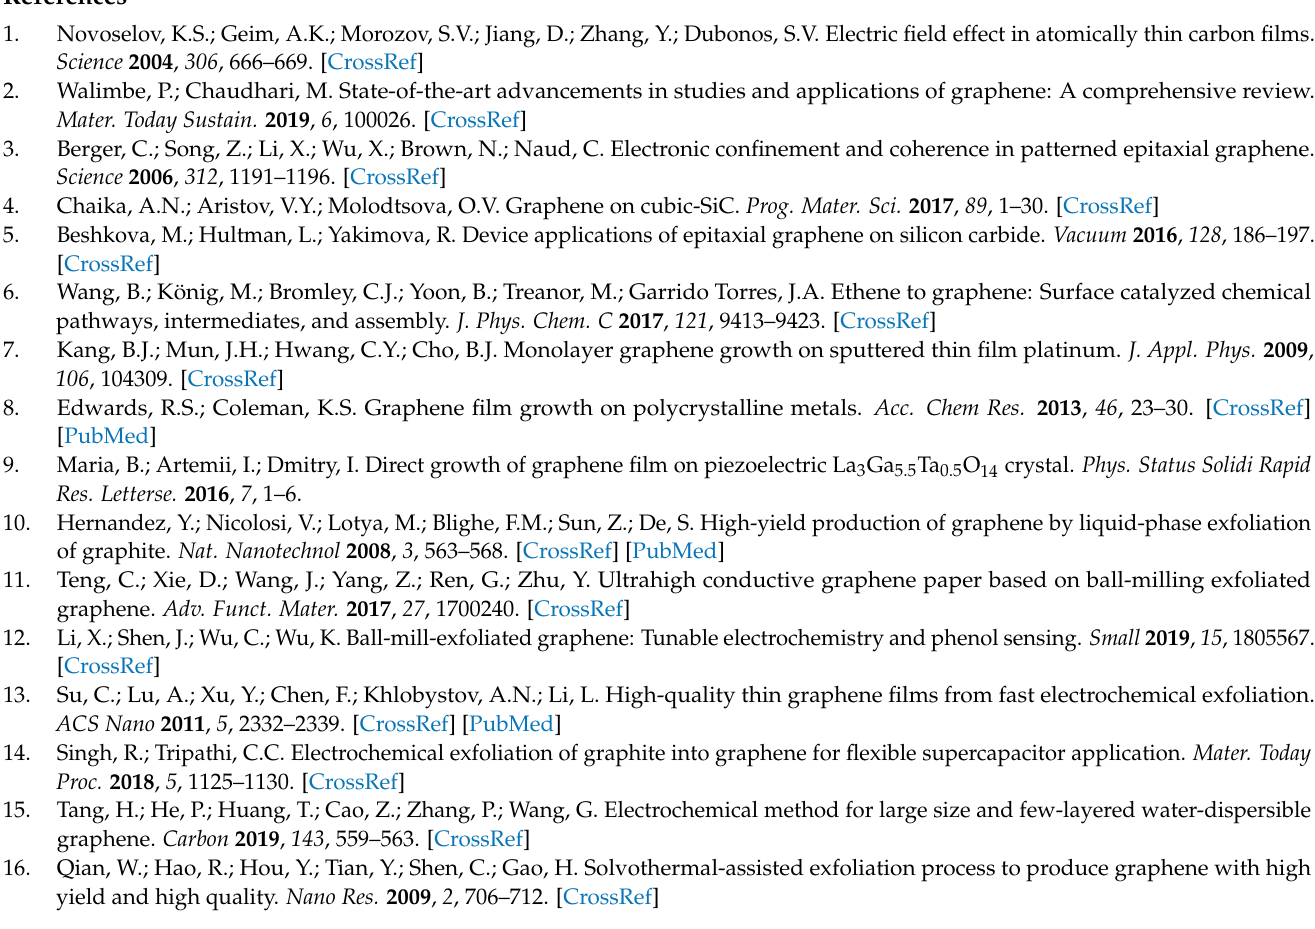
graphite; EGC denotes exfoliated graphite compound, Figure S3: EDS elemental maps for (a) graphite and (b) exfoliated graphite compound. Figure S4: The calculation method of ID/IG ratio in Raman spectroscopy, Figure S5: Dispersions of exfoliated graphite in common solvents (0.5 mg/mL, after 24h), Figure S6: (a) Adsorption kinetics of the exfoliated graphite in an aqueous solution of resveratrol; (b) the pseu-do-first-order adsorption kinetics model; (c) the pseudo-second-order adsorption kinetics model; (d) resveratrol adsorption isotherm of the exfoliated graphite; (e) fitting with the Freundlich model; (f) fitting with the Langmuir model. (Temperature = 30 ◦ C; pH = 4.0), Figure S7: Effect of solution pH (a) and ionic strength (b) on the adsorption of resveratrol onto exfoliated graphite (temperature = 30 ◦ C), Figure S8: Recycling performance of exfoliated graphite (temperature = 30 ◦ C; pH = 4.0; eluent: ethanol), Figure S9: UV–Vis spectra and fitting curve for resveratrol adsorption on the exfoliated graphite from solutions with different resveratrol concentrations, Table S1: Structural parameters of the exfoliated graphite from the XRD data, Table S2: Kinetic parameters and isotherm fitting parameters for the adsorption of resveratrol on the exfoliated